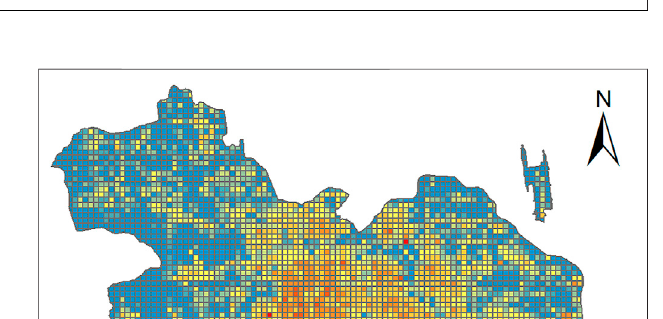
FIGURE 3 | POI kernel density plots of 2013 and 2019.